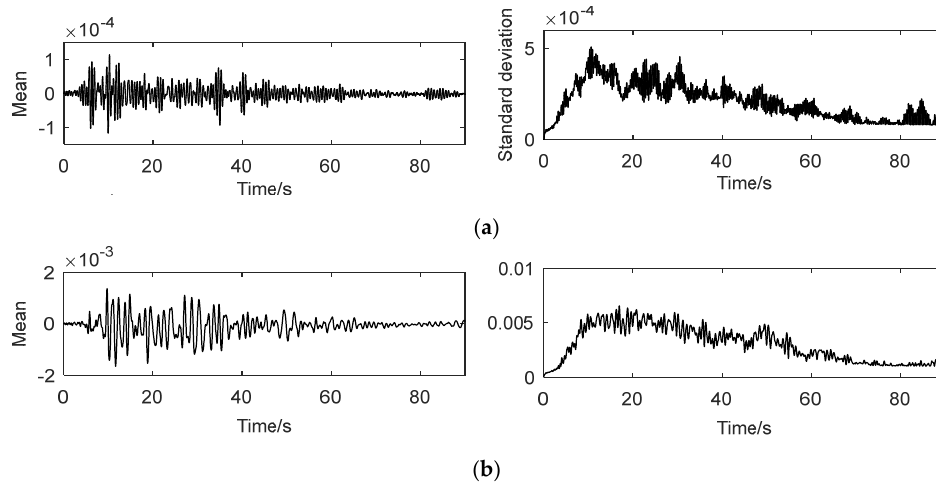
Figure 15. Mean value and standard deviation time histories of story drift angles of the third story excited by stochastic simulated seismic ground motions of site IV group 3: ( a ) frequent earthquakes and ( b ) rare earthquakes.